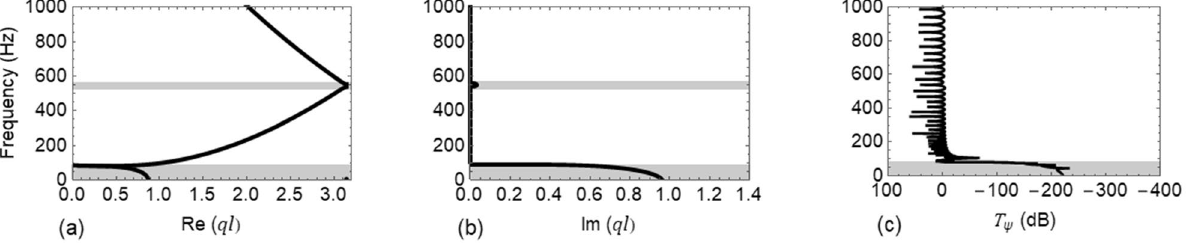
Figure 5. Dispersion curves and transmittance T ψ ( dB ) of Wave #A: ( a ) real part of the dispersion relation, Re ( ql ) ; ( b ) imaginary part of the dispersion relation, Im ( ql ) ; and ( c ) T ψ ( dB )